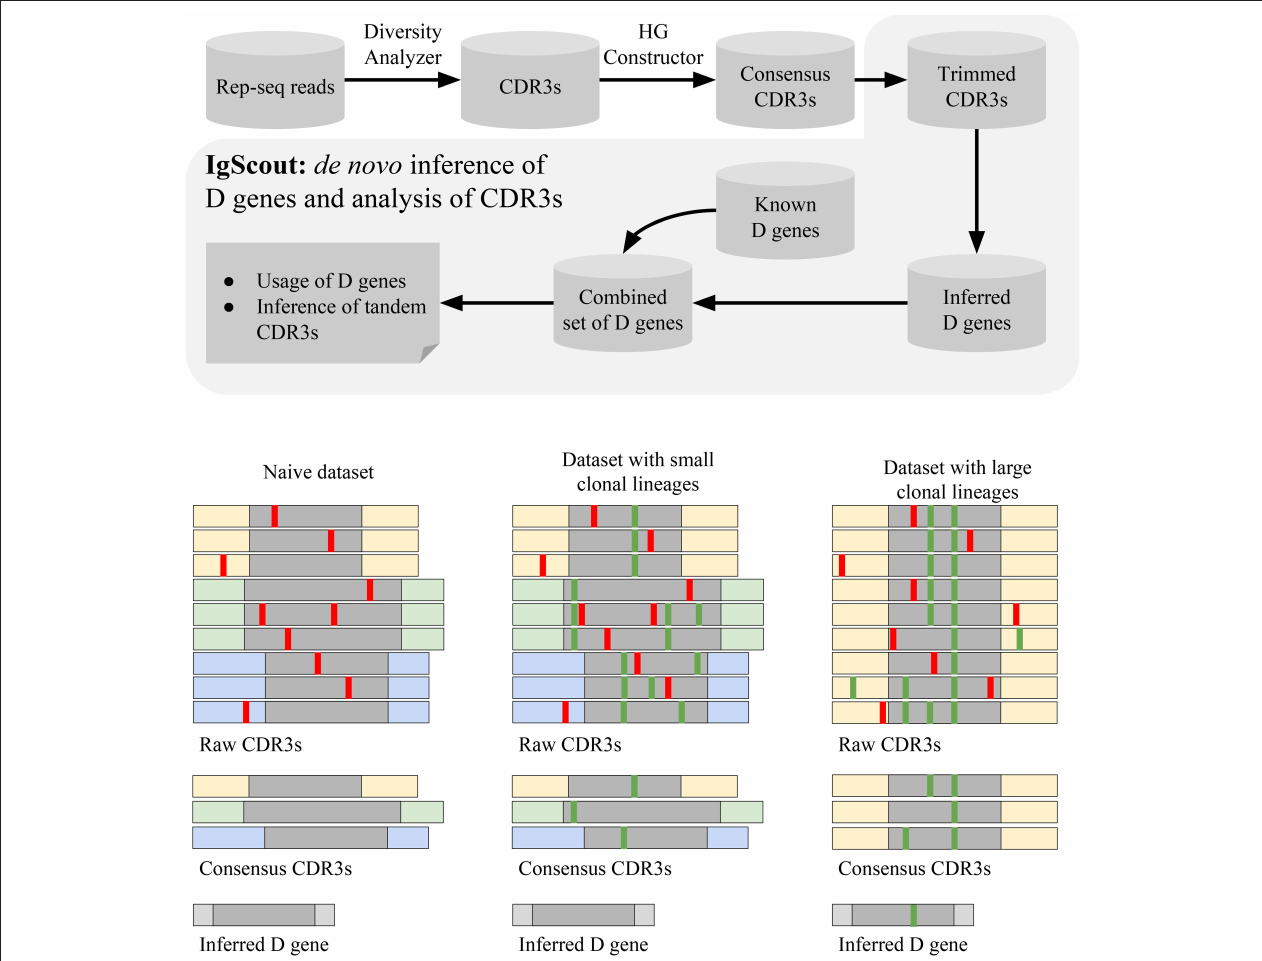
FIGURE 3 | The IgScout pipeline. (Top) IgScout steps. (Bottom) . IgScout performance on a hypothetical naive dataset (left), a dataset with small clonal lineages (middle) , and a dataset with large clonal lineages (right). We assume that all CDR3s are derived from the same D gene (shown in gray). CDR3s corresponding to the same ancestral VDJ recombination are shown by the same color. Sequencing and amplification errors are shown in red; somatic hypermutations are shown in green. The reconstructed (missing) part of the inferred D gene is shown in gray (light